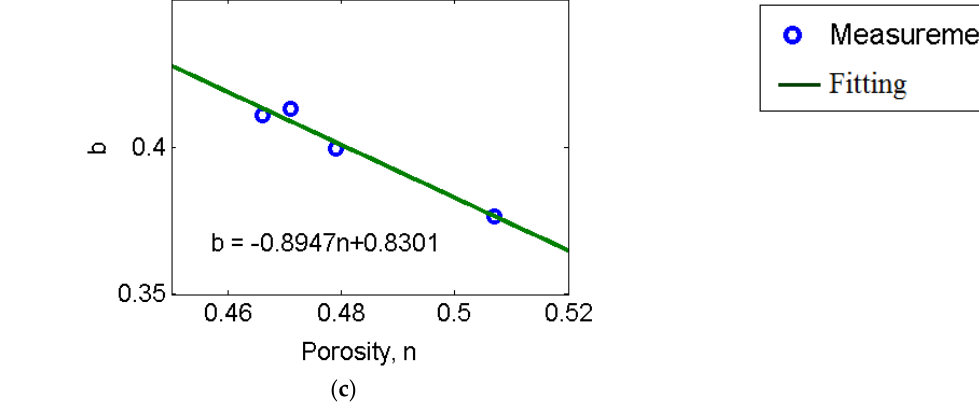
Figure 8. The Fitting Result of the Parametric Functions, ( a ) Equation (4b); ( b ) Equation (4c); ( c ) Equation (4d).